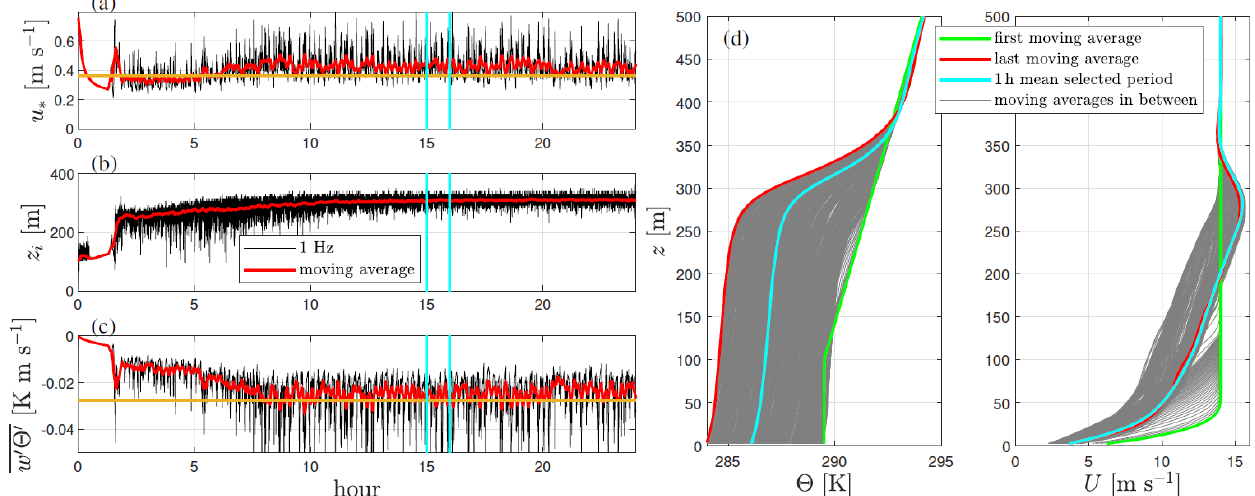
Figure 5. Similar to Fig. 4 but for the stable ABL